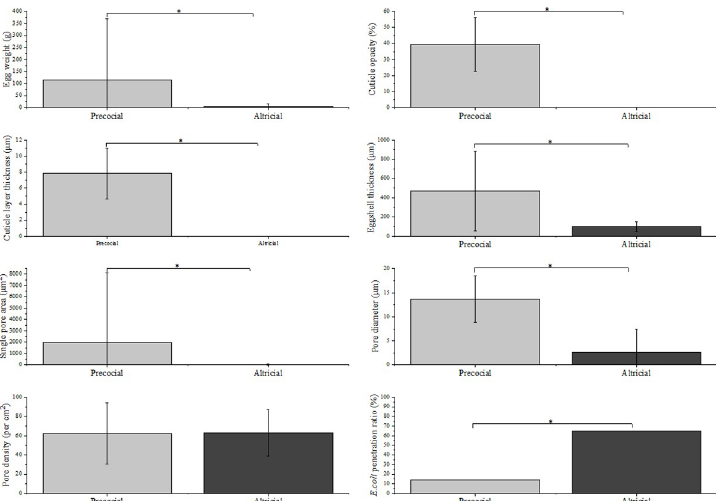
Fig 8. The difference in eggshell traits and E . coli penetration ratio between precocial and altricial birds’ eggs. A significant difference in eggshell traits and E . coli penetration ratio between precocial and altricial birds’ eggs is indicated by an asterisk ( �